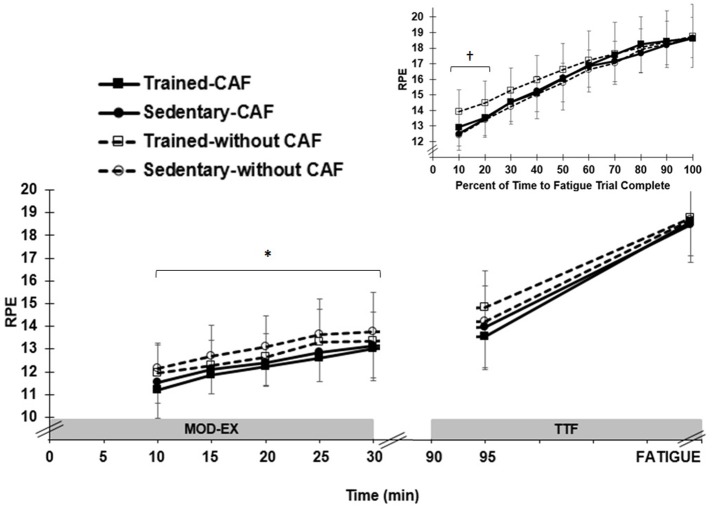
Mean (±SD) rating of perceived exertion (RPE) by group (trained and sedentary) and treatment (caffeinated CAF vs. no CAF) during moderate exercise (MOD-EX) and time to fatigue (TTF). *Significant (p < 0.01) lower RPE with CAF compared to no CAF. Upper right panel: RPE normalized by percentage of trial completed during TTF. †Significantly higher (p < 0.05) RPE in trained participants without CAF during first 20% of TTF.